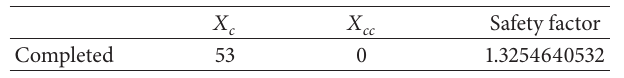
Table 12: Critical failure surface and minimum safety